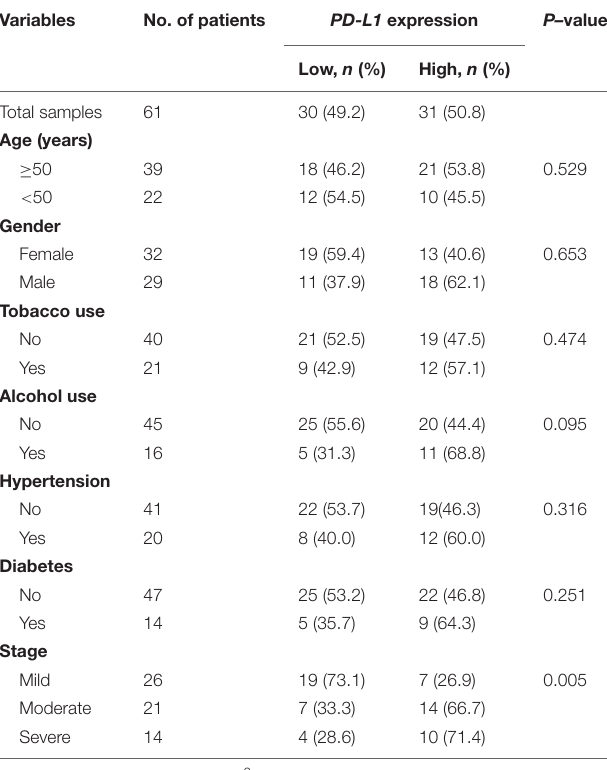
TABLE 2 | The clinicopathological characteristics related to PD-L1 expression in periodontitis patients.